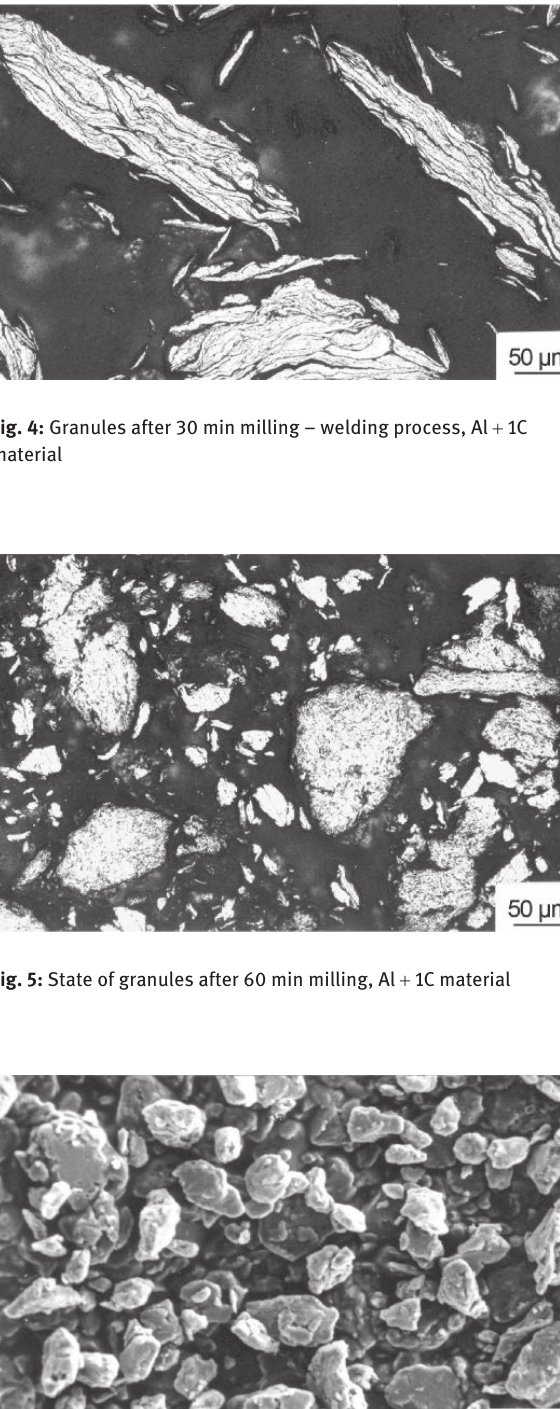
Bereitgestellt von | De Gruyter / TCS Angemeldet |